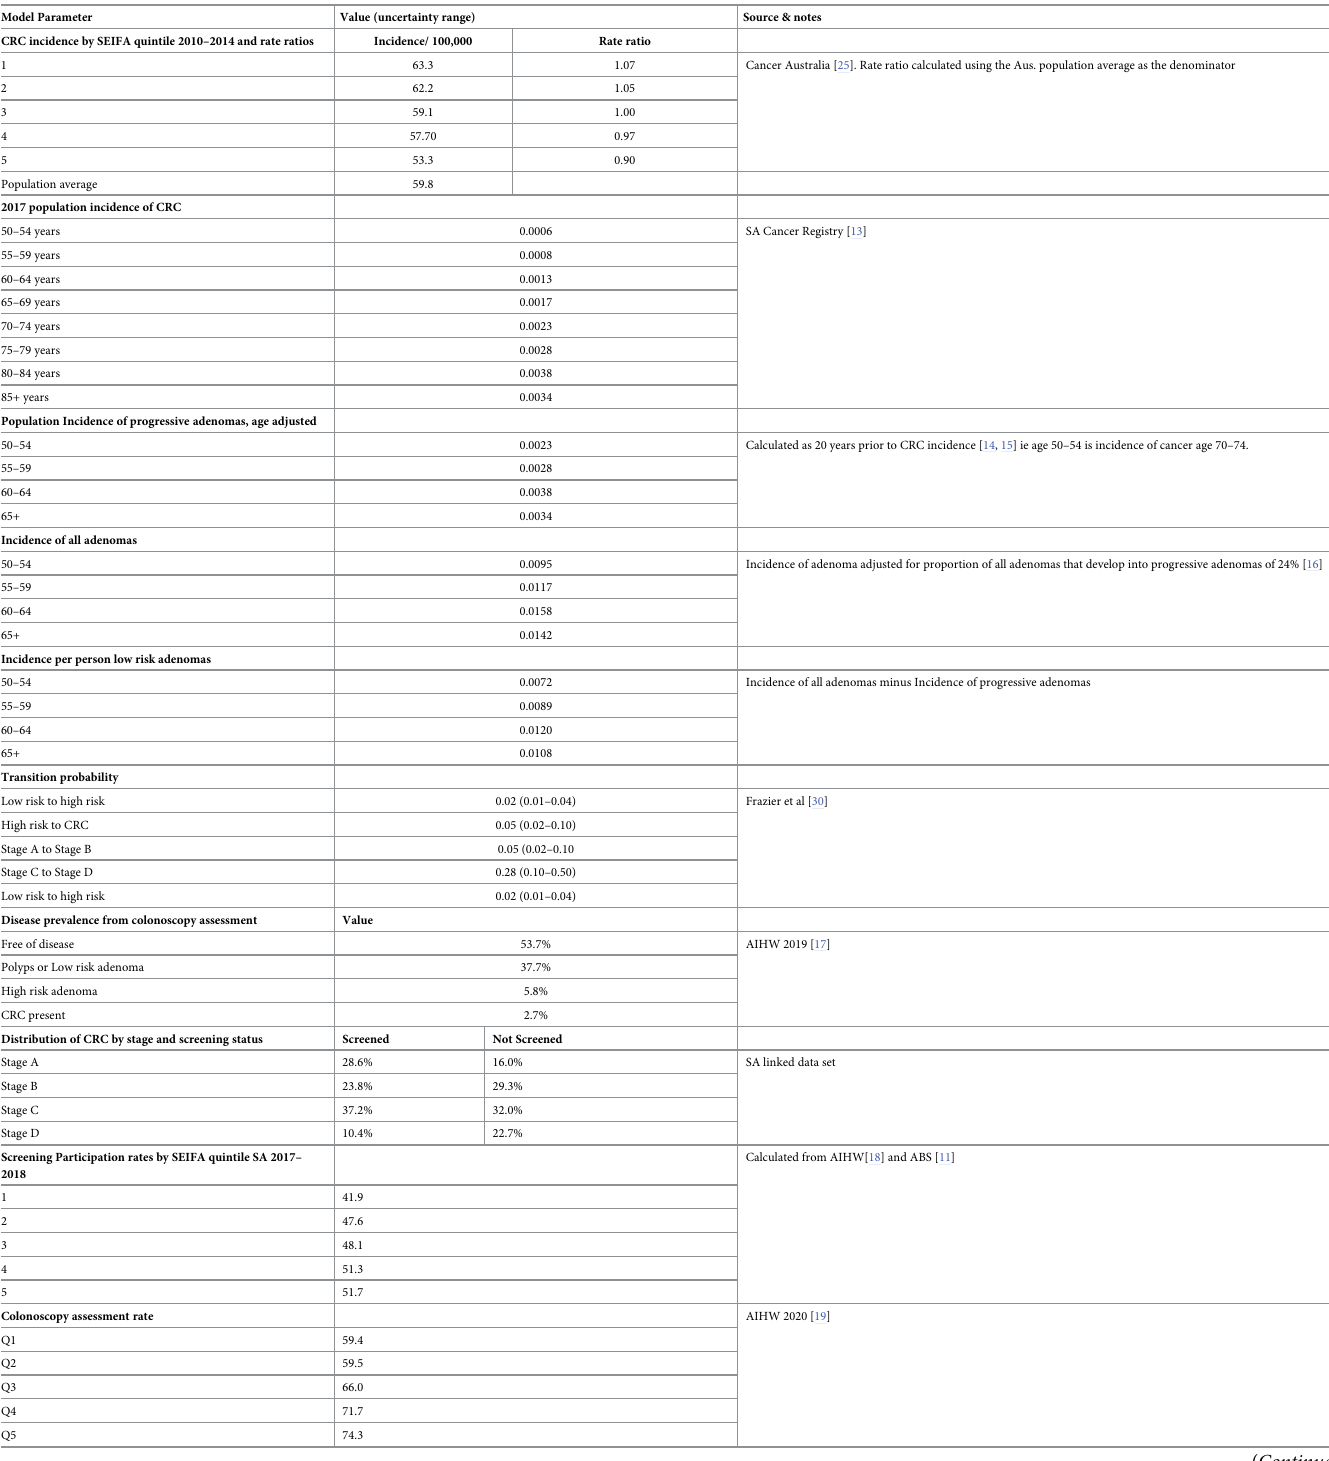
Table 1. Key model parameters used by the Priority Population Microsimulation Colorectal Cancer (PRISM-CRC)